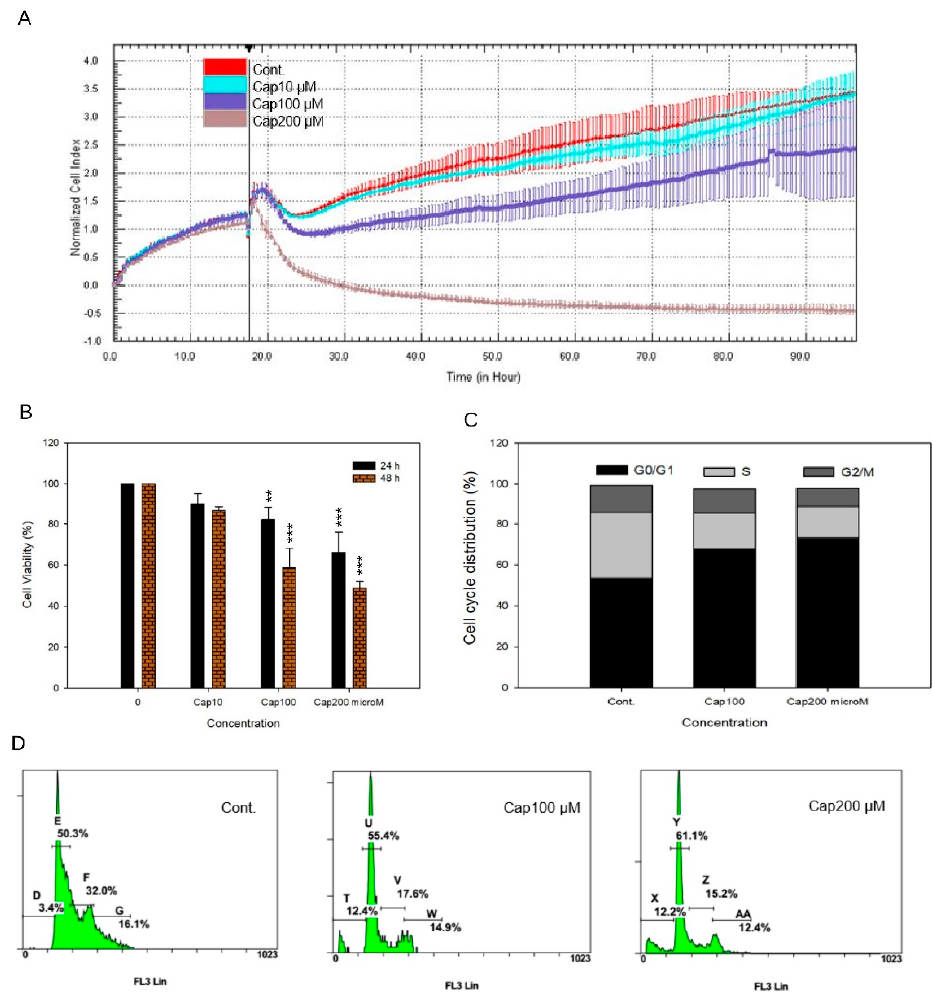
Figure 4. Effect of capsaicin on the proliferation and cell cycle of T24 cells. (A) Dynamic monitoring of cell proliferation was performed using impedance technology, as described in the Materials and Methods section. Normalized cell index values measured over 96 h are shown. (B) Cells were exposed to different concentrations of capsaicin for 24 or 48 h and cell viability was measured using MTT assays. Values (means ± SDs) are from three independent experiments. There was a significant decrease in cell viability in cells treated with capsaicin when compared with controls (** p <0.01, *** p <0.001). (C, D) T24 cells were exposed to different concentrations of capsaicin for 24 h and flow cytometry was used to assess their cell-cycle phase. The graphs are representative of three independent experiments.